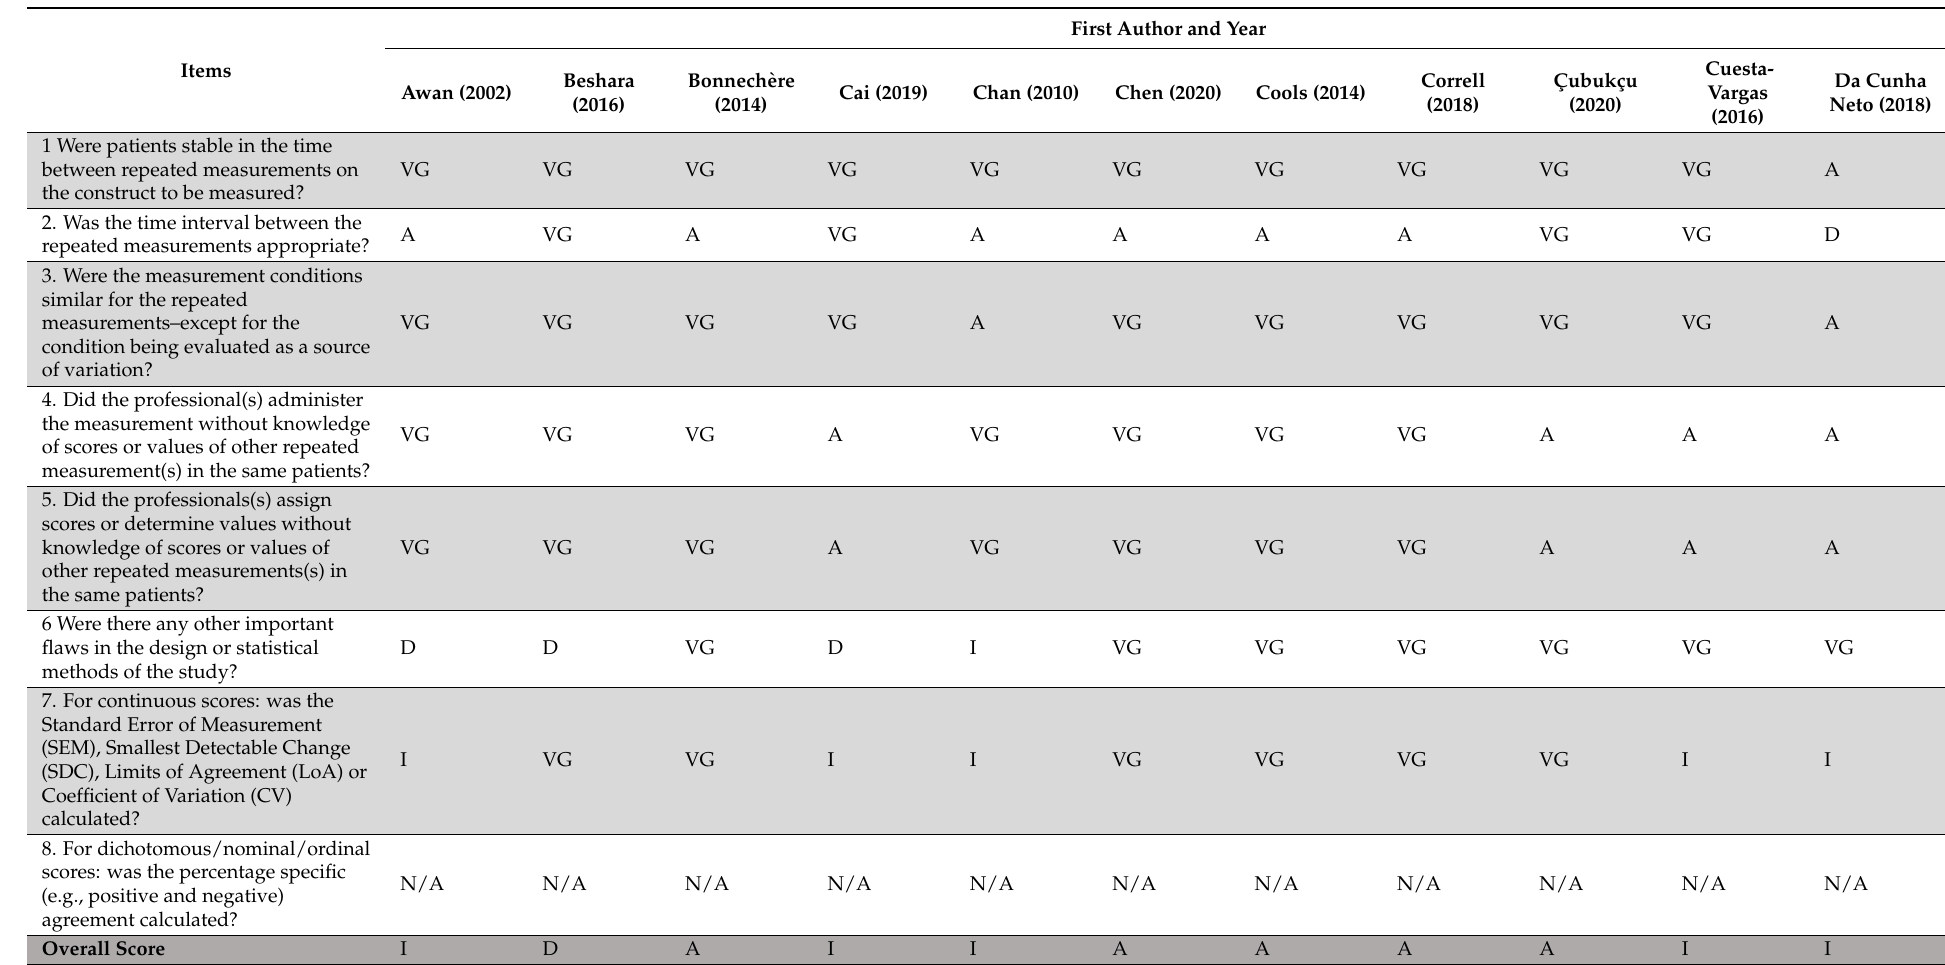
Table 4. Assessment of measurement error using the COSMIN standards for studies on measurement error